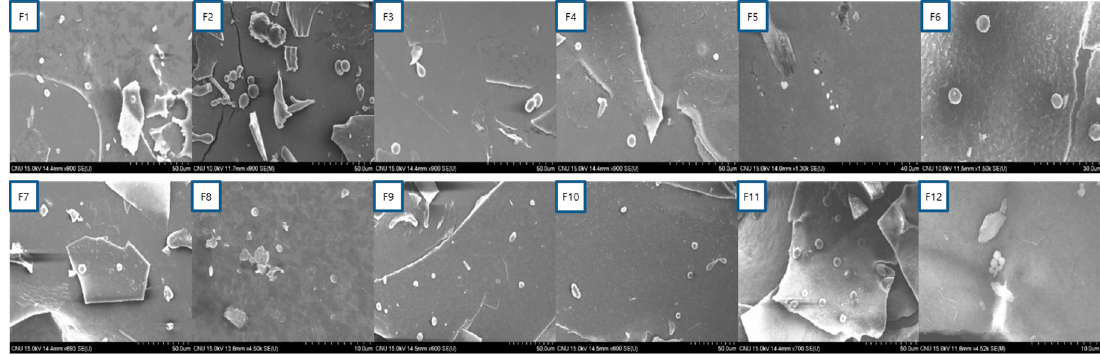
Figure 1. Scanning electronic microscopy images of various H-SLNs.